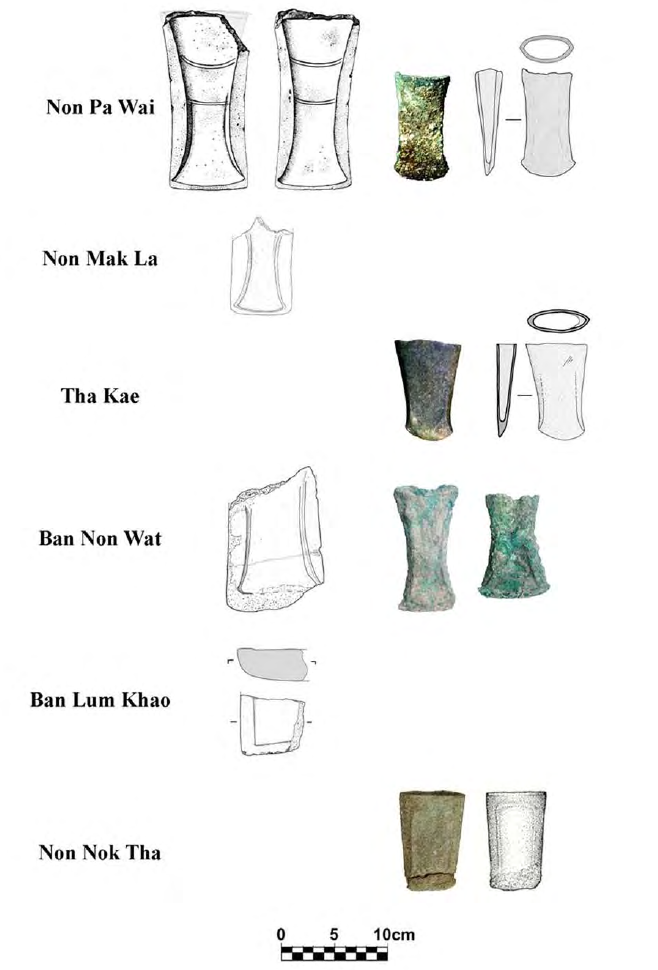
Fig. 7: Early Bronze Age moulds and copper base axes from the two regions and from Non Nok Tha in the northern Khorat